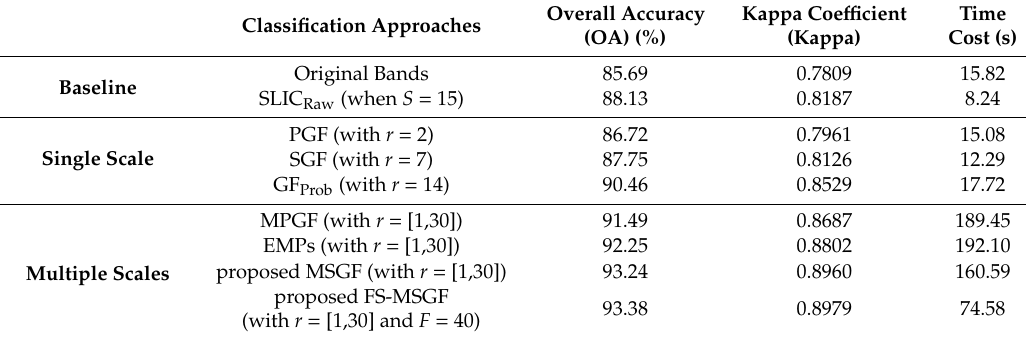
Table 2. Classification results of Zh1 obtained by the proposed and reference methods.